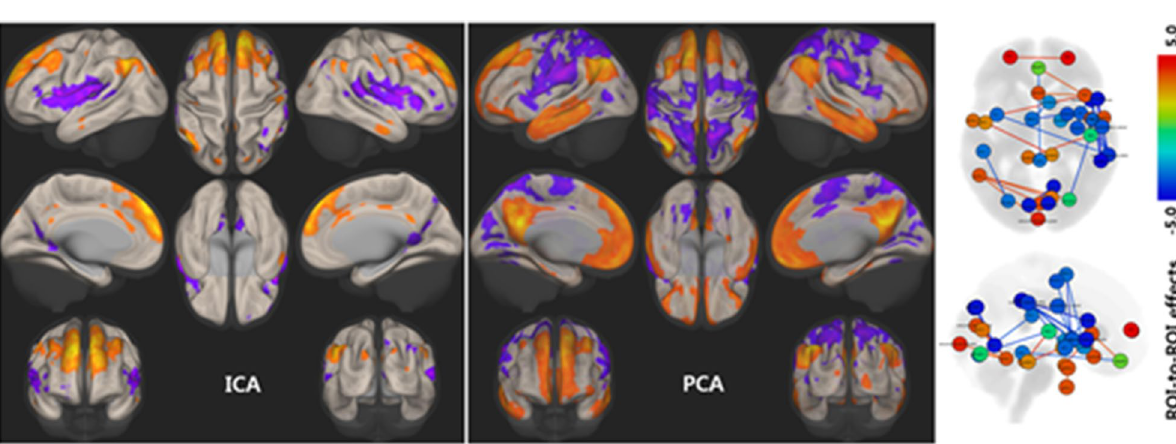
Figure 5. Network analysis of age and BOLD signal change during swallowing. During the 12-min tasks, the BOLD signals of the DMN areas were more positively correlated with age, whereas the BOLD signals of both lateral precentral gyri, postcentral gyri, and insular cortices declined with normal aging. The BOLD signal changes in the ICA and PCA showed similar patterns, although PCA more clearly demonstrated involvement of the DMN. ROI-based network analysis (right panel) suggests age-related decline of the BOLD signal in motor and insular areas, but strengthened networks in DMN areas such as the medial prefrontal, posterior cingulate cortices, dorsal superior frontal, angular gyri, and temporal pole. The color bar depicts t-values. Statistical significance was set at FDR-corrected p < 0.05. BOLD, blood oxygen level-dependent; DMN, default mode network; ICA, independent component analysis; PCA, principal component analysis; ROI, region of interest; FDR, false discovery